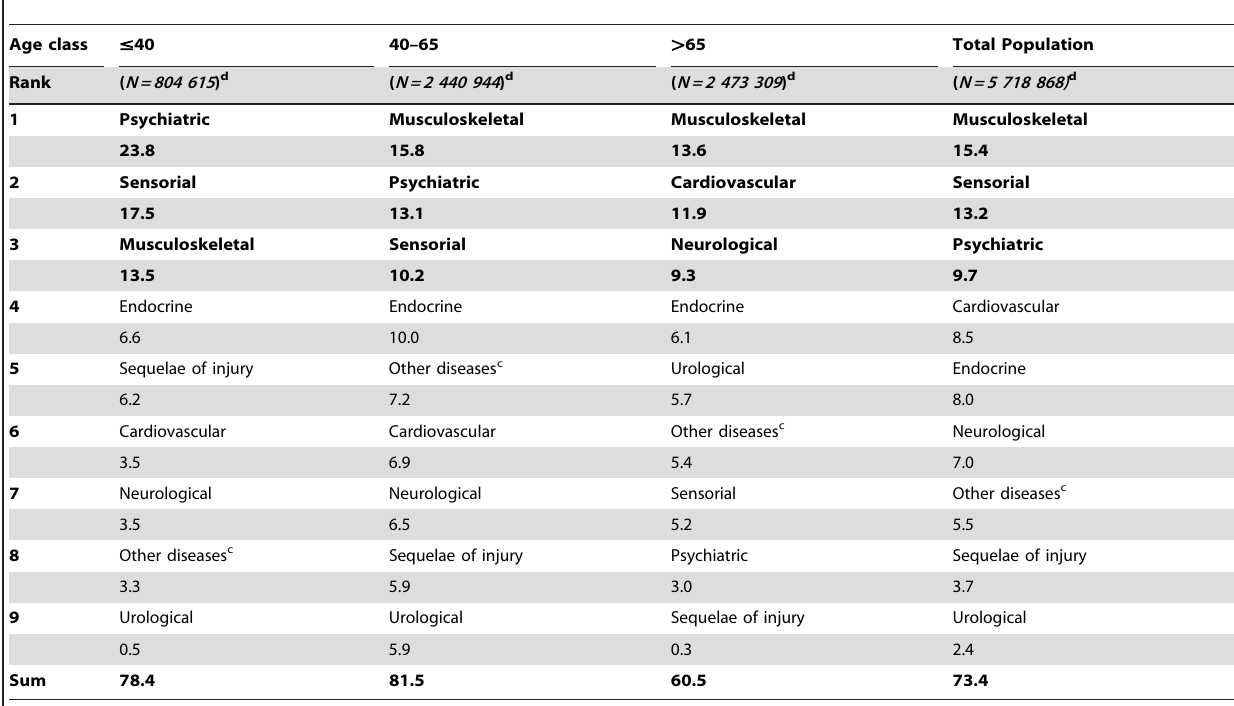
Table 6. Average attributable fraction a (AAF) estimates (%) of chronic conditions for self-reported disability b in